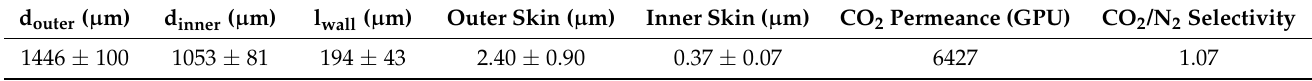
Table 2. Material and transport characteristics of the prepared hollow-fiber substrate